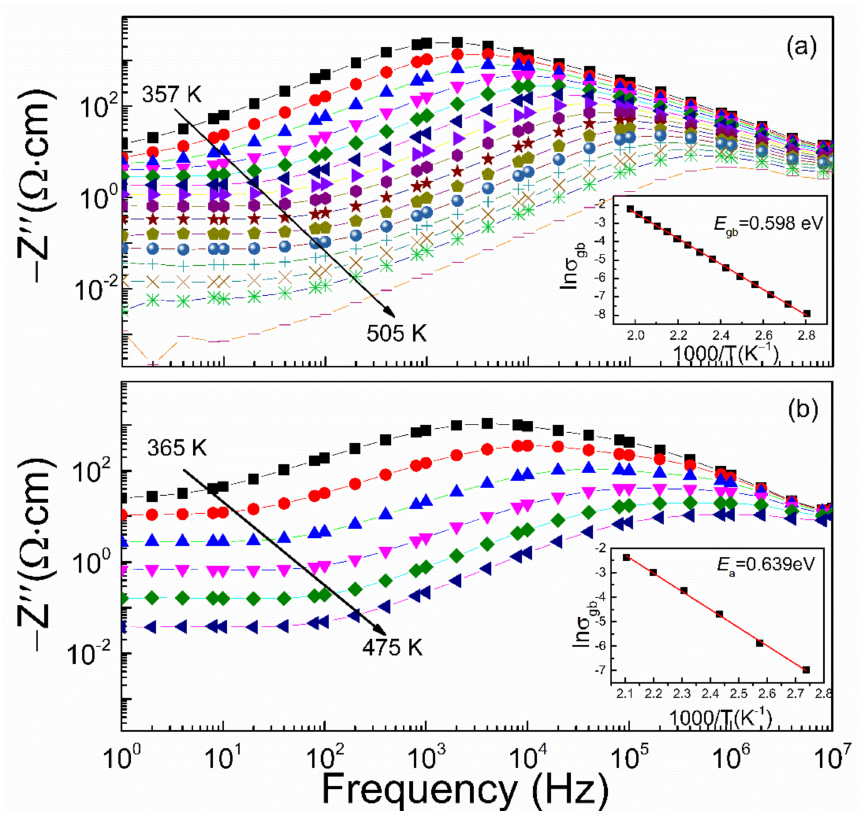
Figure 10. Frequency dependence of Z (cid:48)(cid:48) for La 2/3 Cu 3 Ti 4 O 12 ( a ) and CaCu 3 Ti 4 O 12 ( b ) in the high- T range. Solid symbols in insets are experimental data representing the temperature dependence of grain boundary conductivity σ gb , and the fitting results are shown as red